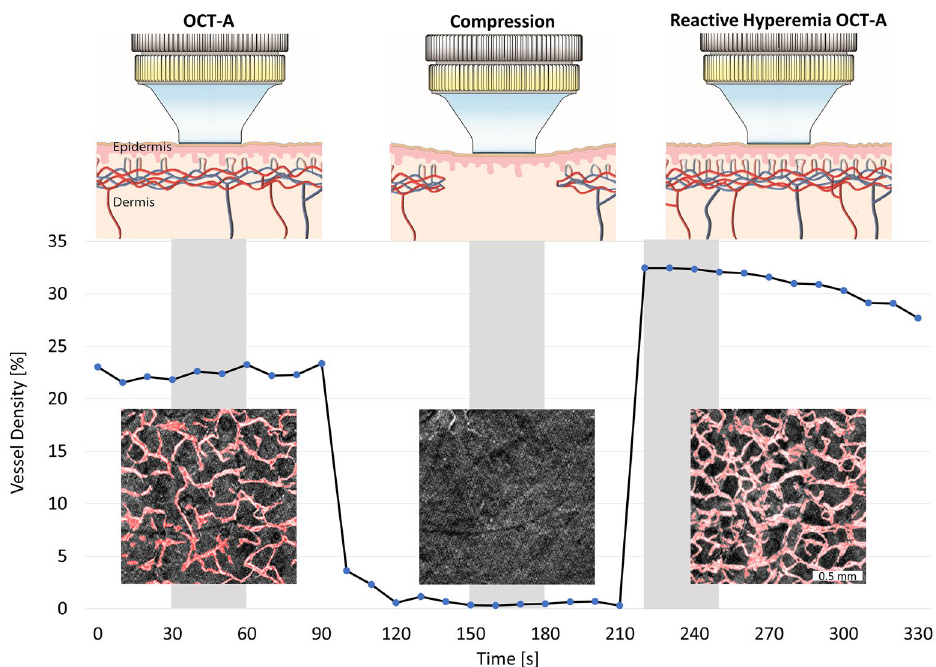
Figure 1. Scheme of the image acquisition protocol and microvascular perfusion response to the application and subsequent release of mechanical stress. For this graph, OCT-A images (1.75 mm × 1.75 mm) of the forearm of a representative young subject were acquired every 10 s. For the rest of the study population, 3 OCT-A images (6 mm × 6 mm) were acquired during the highlighted gray areas. Each image acquisition took 30 s followed by 30 s of data processing and saving. After the baseline OCT-A image is captured, mechanical stress (20–90 kPa) is induced for 2 min. In the meantime, the compression state image is acquired. Immediately after releasing the compression, the reactive hyperemia OCT-A image is taken. OCT-A images are shown with the resulting automatic vessel segmentation map overlaid in red, which also constitutes the vessel density